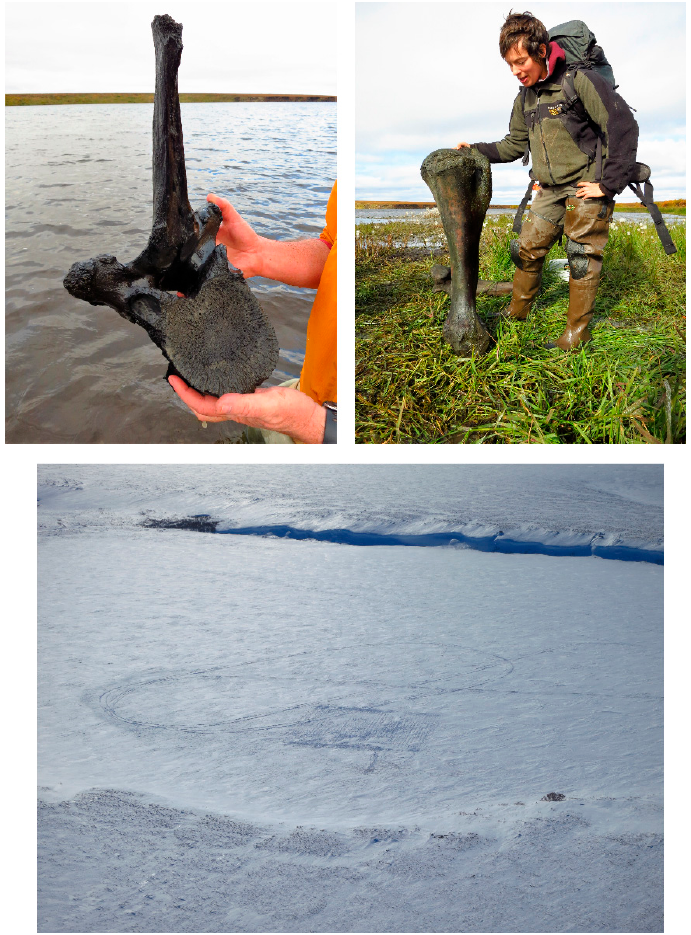
Figure 14. Top : Mammoth vertebra ( left ) and humerus ( right ) located in 2012. NPS photo, J. Rasic. (Shown: Louise Farquharson); Bottom : View of the mammoth bone scatter survey area from the air. Photo by J. Rasic 2015. The landing track of the plane as well as the grid pattern of the completed GPR survey are visible.